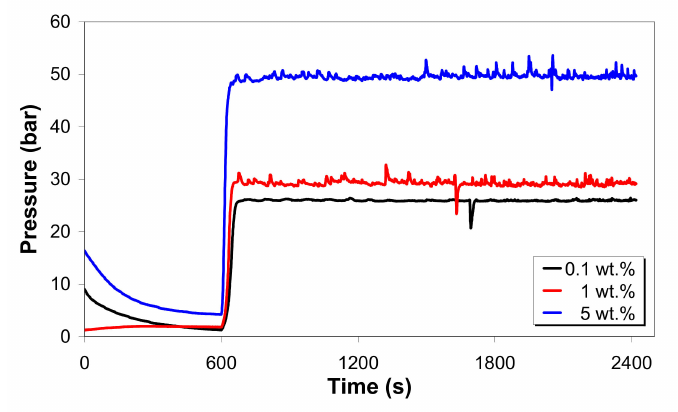
Figure 2. Pressure versus time at a 200 s − 1 apparent shear rate and 130 ◦ C melt temperature (capillary die ratio, L / D =